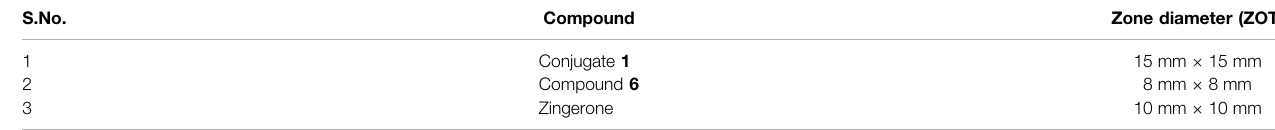
TABLE 3 | QSI activity of different compounds against Pseudomonas aeruginosa PAO1. S.No.